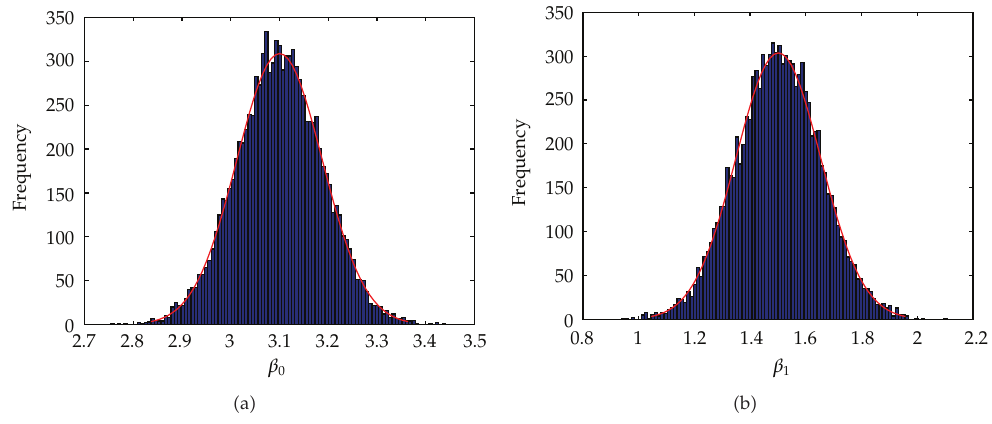
(cid:9) β (cid:9) β (cid:6) a (cid:7) (cid:9) β (cid:6) b (cid:7) (cid:9) β 0 and 1 : 0 , 1